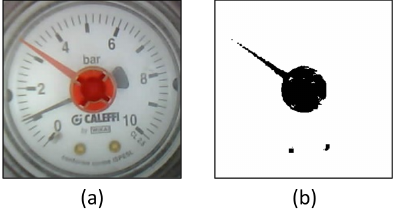
Figure 7. Tell-tale pointer segmentation. ( a ) original image, ( b ) tell-tale pointer segmented.